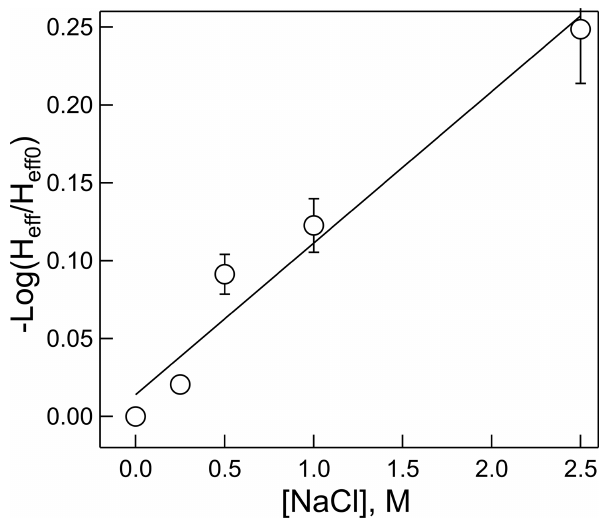
Figure 6. Dependence of the effective Henry’s coefficient ( H eff ) at a given salt concentration, relative to that with no added salt ( H eff0 ) versus NaCl molarity. R 2 = 0 .